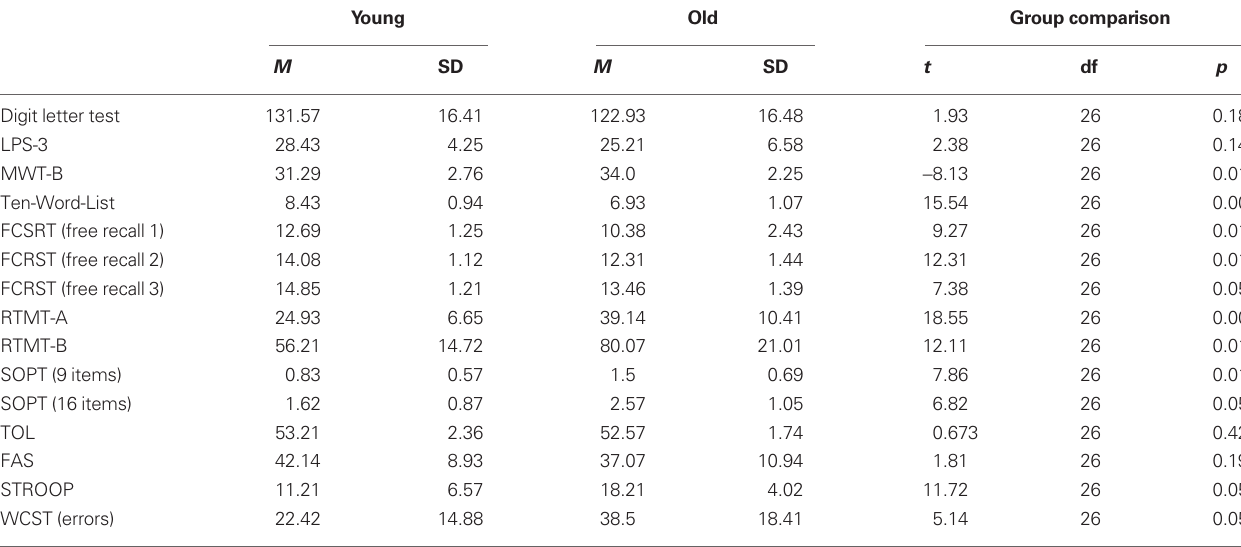
Table 2 | Descriptive statistics for tests assessing general intellectual abilities for younger and older